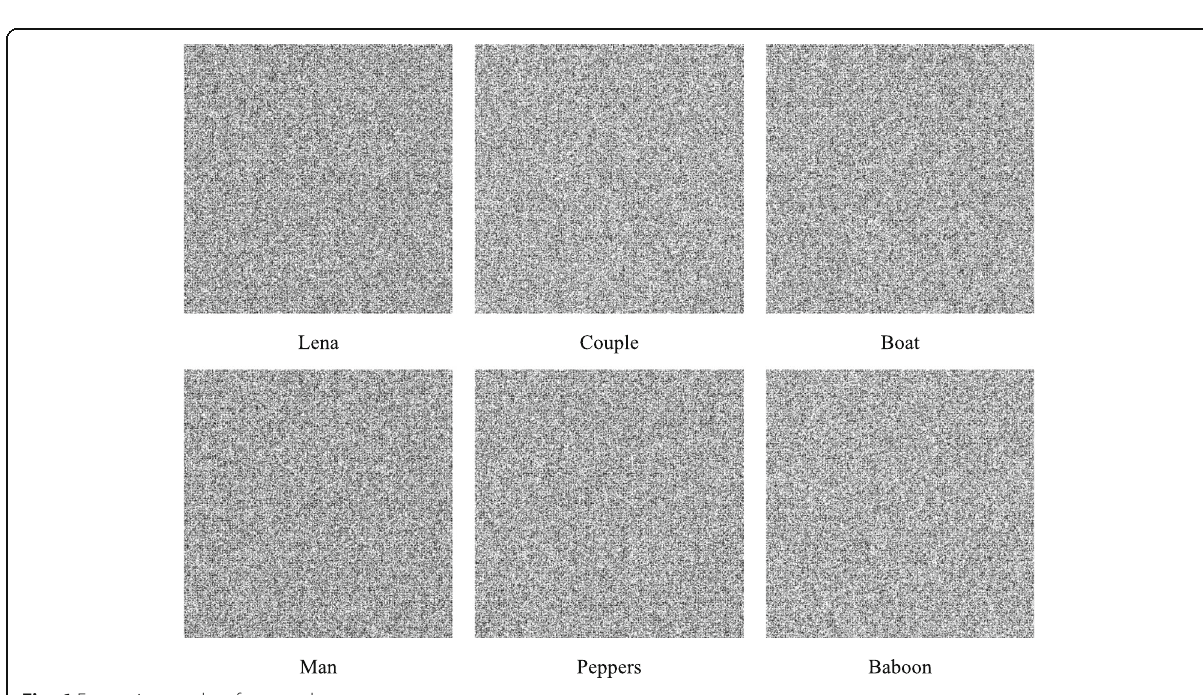
Fig. 6 Encryption results of our